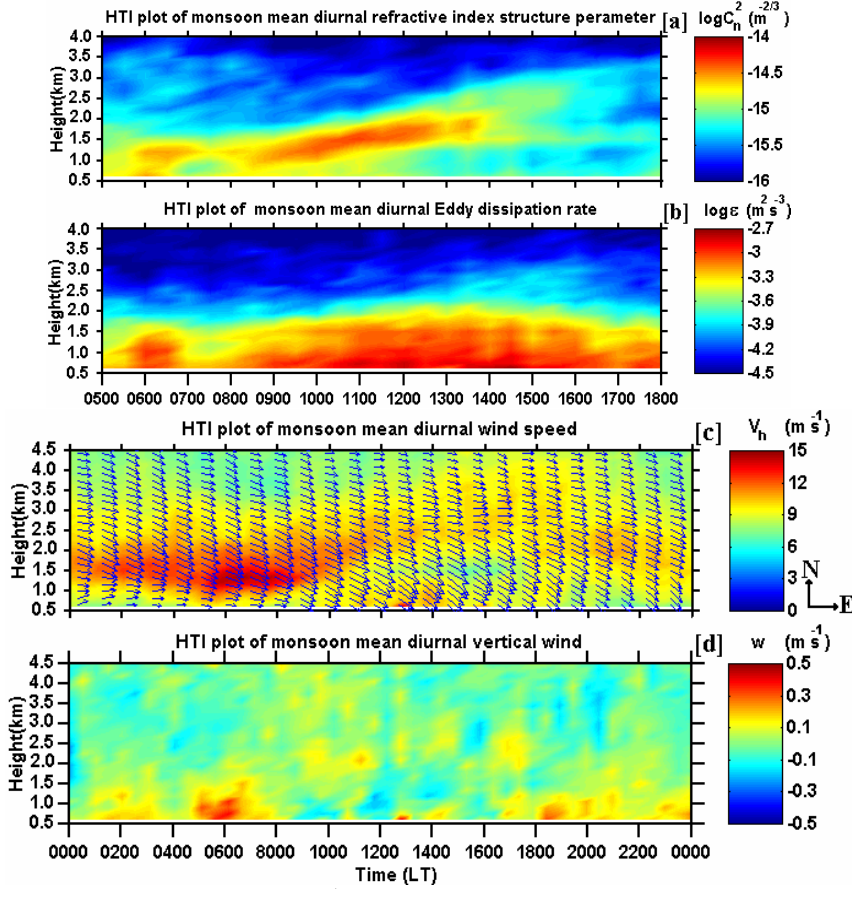
Fig. 6b. Monsoon seasonal diurnal features of (a) C 2 n , (b) ε , (c) V h , and (d)